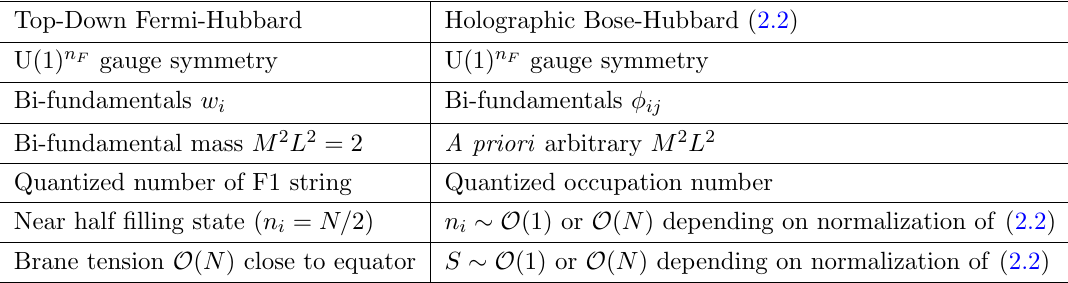
Table 3 . Comparison of top-down with bottom-up